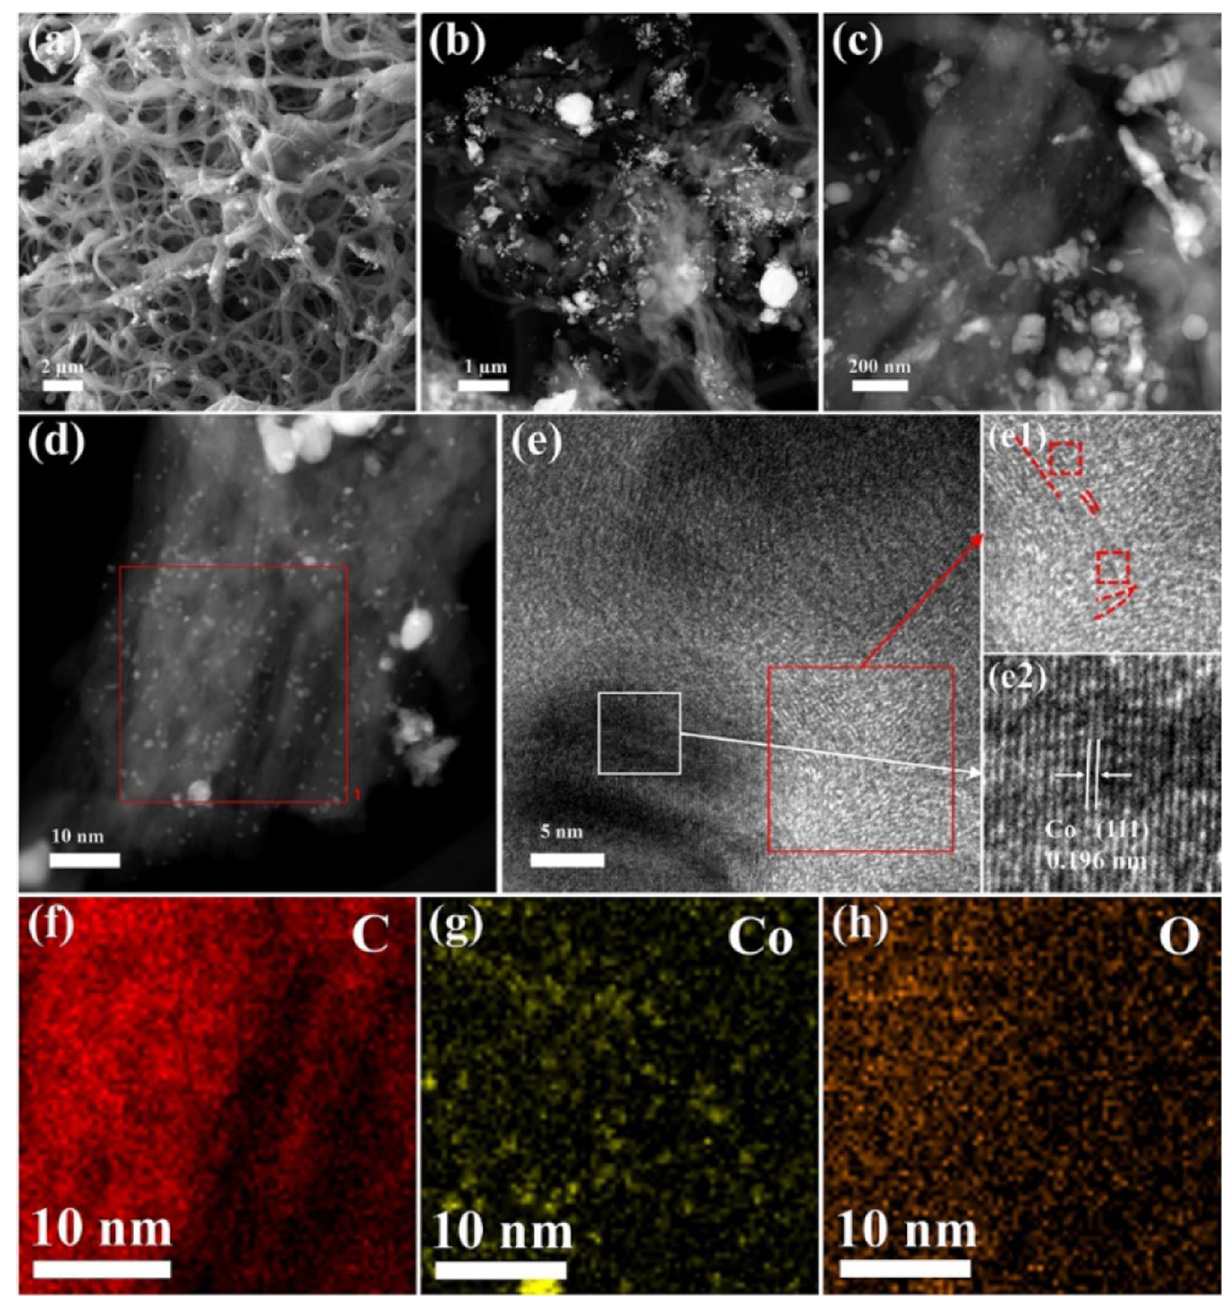
Figure 3. SEM images ( a – c ) under different magnification, ( d ) STEM image, ( e ) HRTEM image of Co/PCNF; ( e1 ) crystal plane of the carbon around the pore and ( e2 ) crystal plane of CoNPs particles embedded in the samples; elemental mapping of Co/PCNF in some area of Co/PCNF: ( f ) carbon mapping; ( g ) cobalt mapping; ( h ) oxygen mapping.